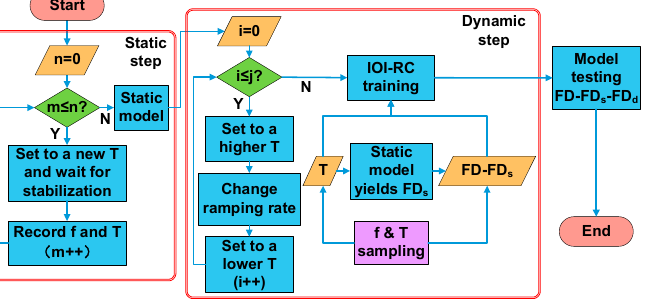
Figure 5. Flow chart of the temperature experiment steps. Max–min temperature values as well as the ramping rate are quite varied, which makes the dataset diverse. Sampling temperature goes through the static model and the output is sent to IOI-RC, and then the dynamic model is trained and tested.